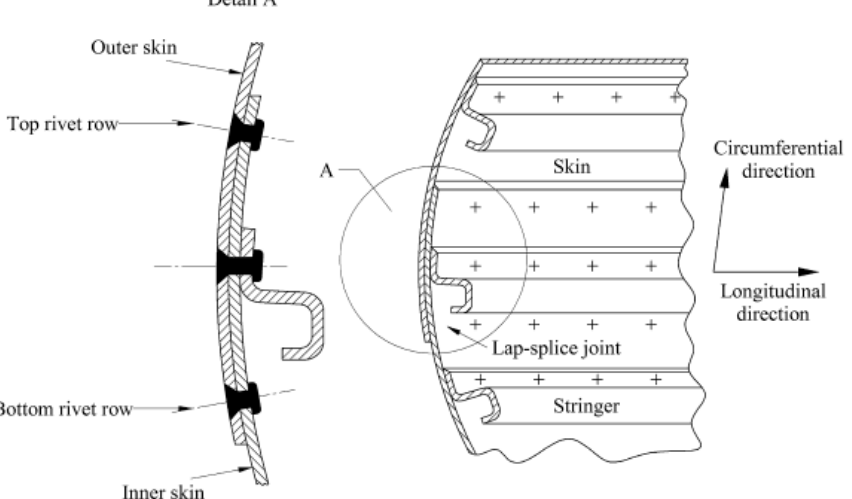
Figure 1. Typical fuselage longitudinal riveted lap joint [2] Reproduced with permission from Skorupa, A; INT. J. FATIGUE, published by Elsevier, 2014.